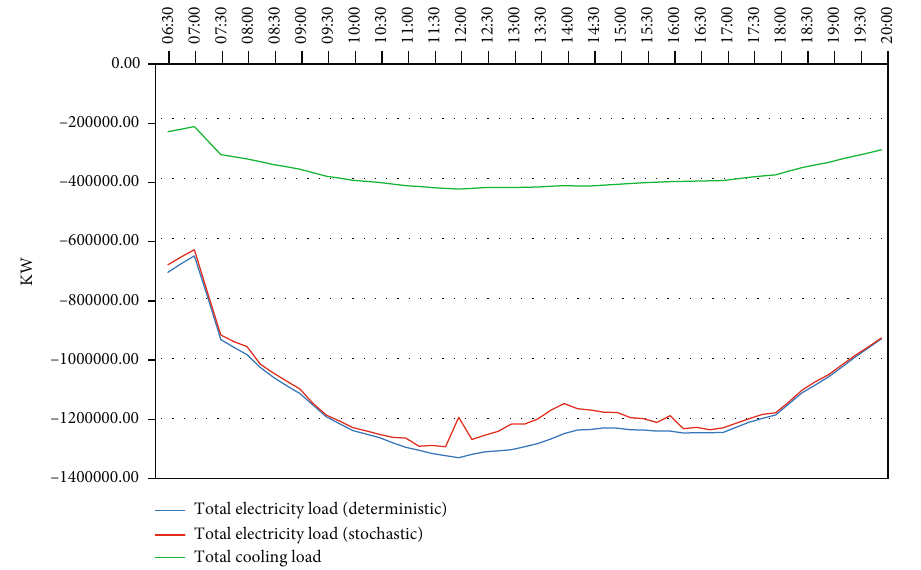
Figure 18: Basic electricity consumption and comparison of stochastic and deterministic electric load (day). Table 11: Behavioral fl exibility potential of cooling energy consumption by di ff erent building groups (day).